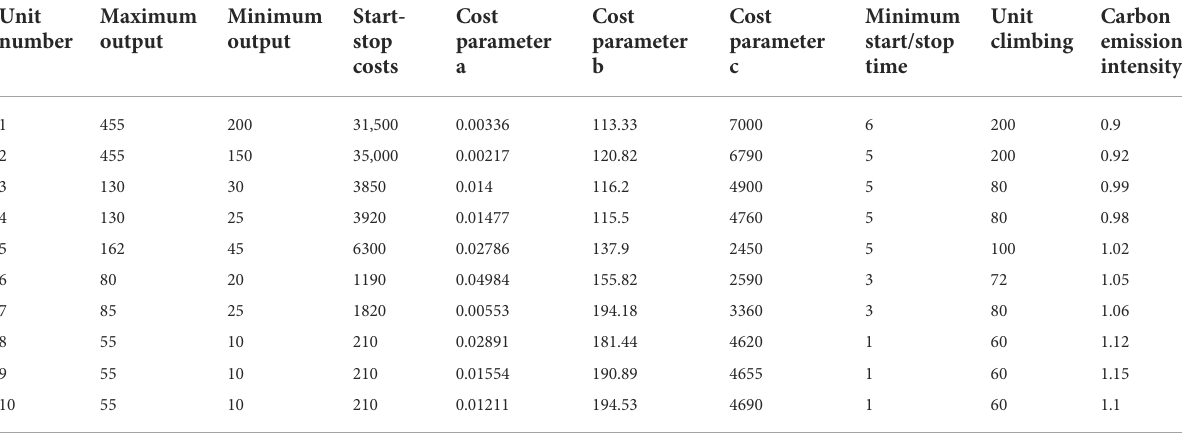
TABLE 1 Thermal power unit parameters (Total of 10 thermal units; input parameters include operation, cost, climbing parameters and carbon capture intensity) (Shui et al., 2019). Unit number